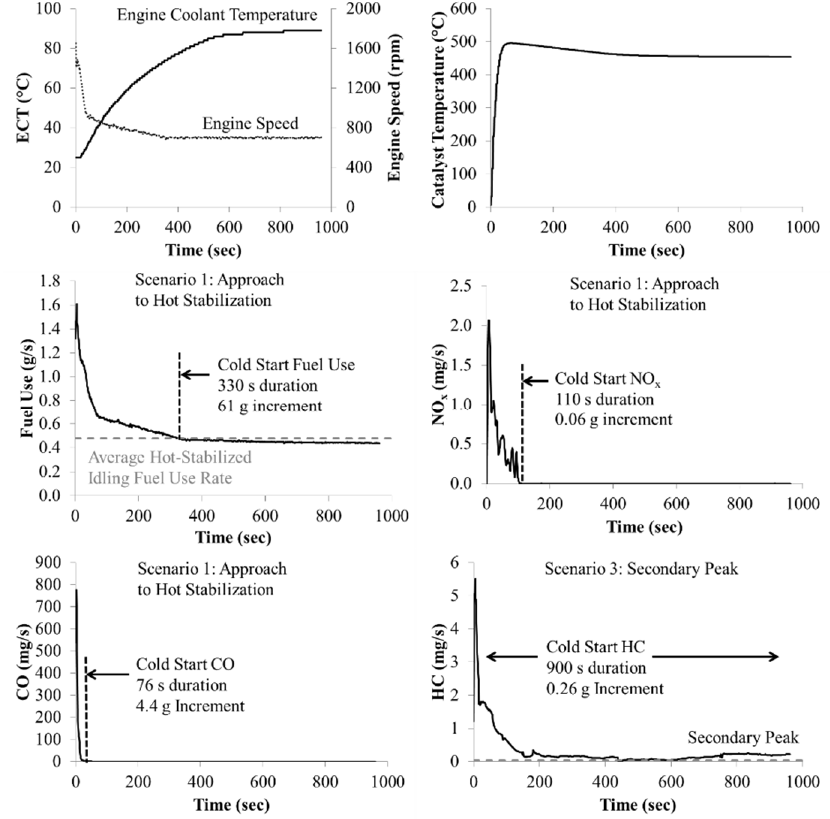
Figure 5. Example of time-based measured idle cold start result, including engine speed, engine coolant temperature (ECT) ( upper left ), catalyst temperature ( upper right ), fuel use rate ( middle left ), and emission rates of nitrogen oxides ( middle right ), carbon monoxide ( bottom left ), and hydrocarbons ( bottom right ) for a 2008 Chevrolet Impala, with 26 °C ambient temperature, 81 percent relative humidity, and 12 h soak time.